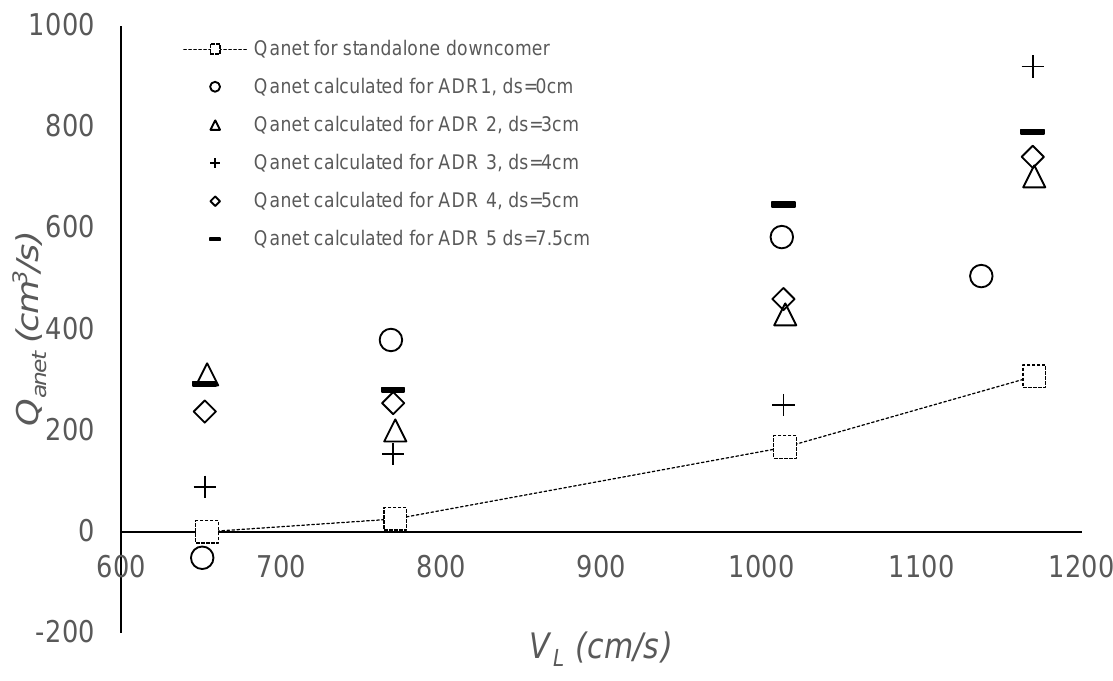
Figure 16. The effect of standalone downcomer vs. novel ADR downcomer on Q anet for CPLJR with Dc = 7.4 cm, L j = 45 cm, H c = 46 cm and d n = 8.1 mm.